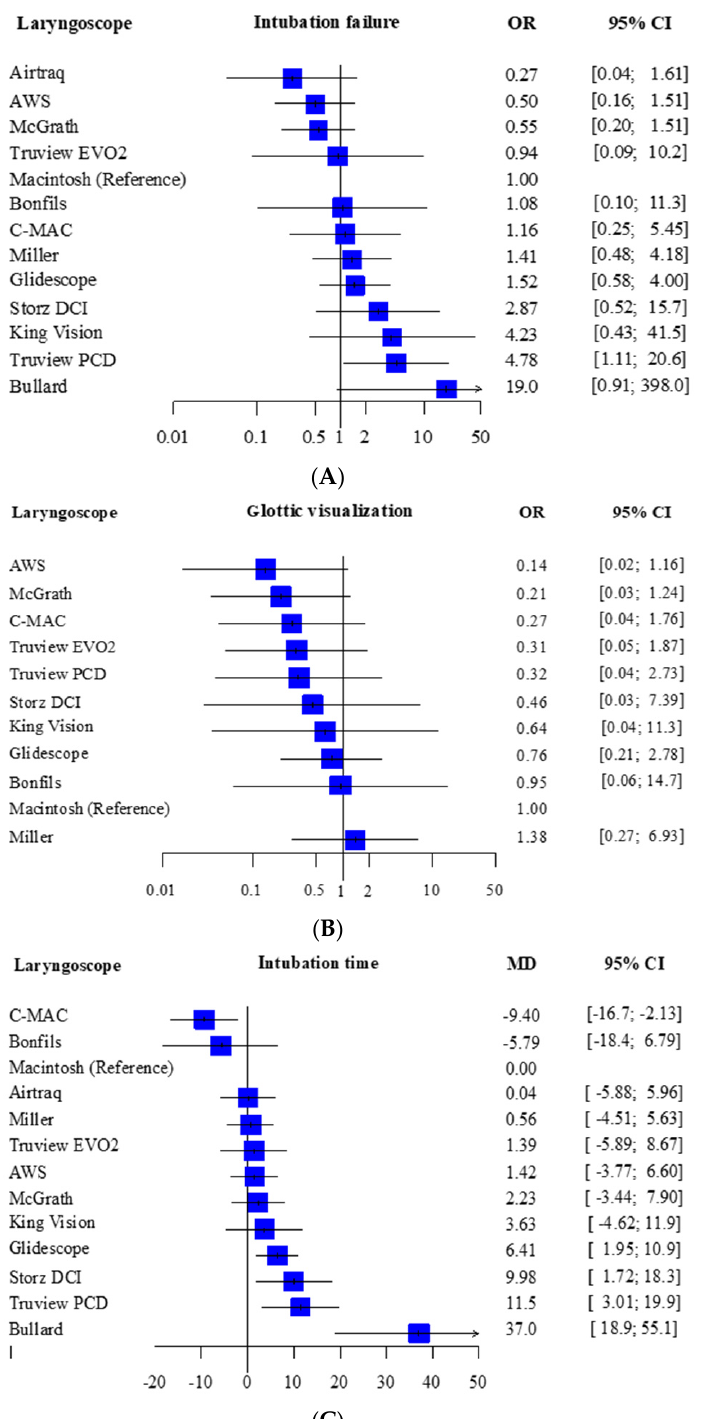
Figure 2. Forest plot of the main results. ( A ) Forest plot of the intubation failure of tracheal intubation using the indirect laryngoscope compared with the Macintosh laryngoscope. ( B ) Forest plot of glottic visualization with the indirect laryngoscope compared with the Macintosh laryngoscope, Cormack– Lehane grade 1 and 2 vs. other grades. ( C ) Forest plot of intubation time for tracheal intubation using the indirect laryngoscope compared with the Macintosh